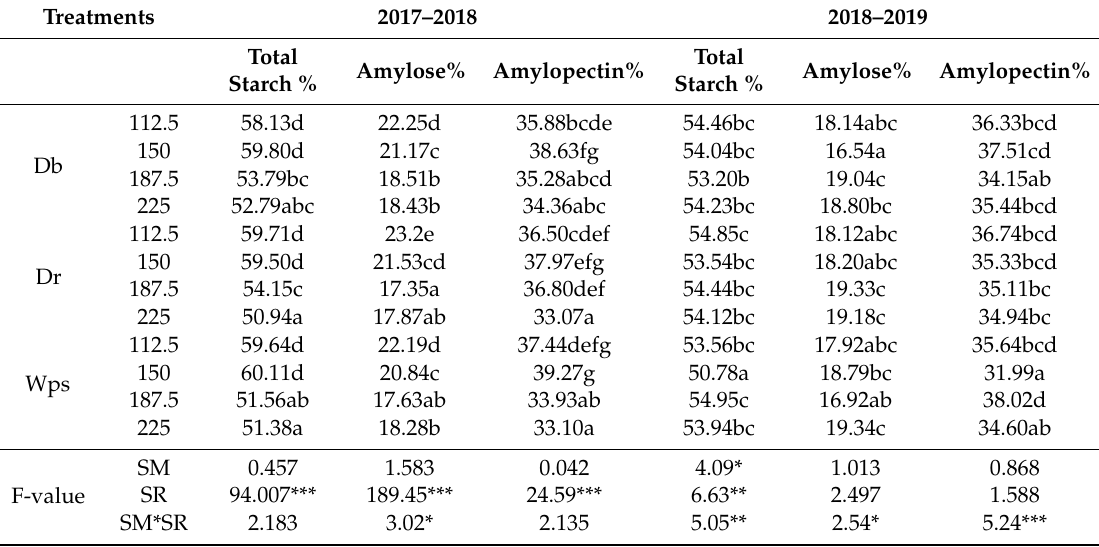
Figure 7. The e ff ects of the sowing methods and seed rate on the total protein % in both cropping seasons. ( a , b ) represent total protein % in first and second season respectively. Db, Dr, and Wps represent the sowing methods dibbling, drilling, and wide precise sowing, respectively. In summary, 112.5, 150, 187.5, and 225 represent the winter wheat (Xinong805) sown at 112.5 kg ha − 1 , 150 kg ha − 1 , 187.5 kg ha − 1 , and 225 kg ha − 1 , respectively. The vertical bars represent the standard errors ( n = 3); in the same protein fraction, the same letters above the bars indicate no significant di ff erences between the di ff erent treatments ( p < 0.05). Table 8. The e ff ects of the sowing methods (SM) and seed rate (SR) on starch and its components in both cropping